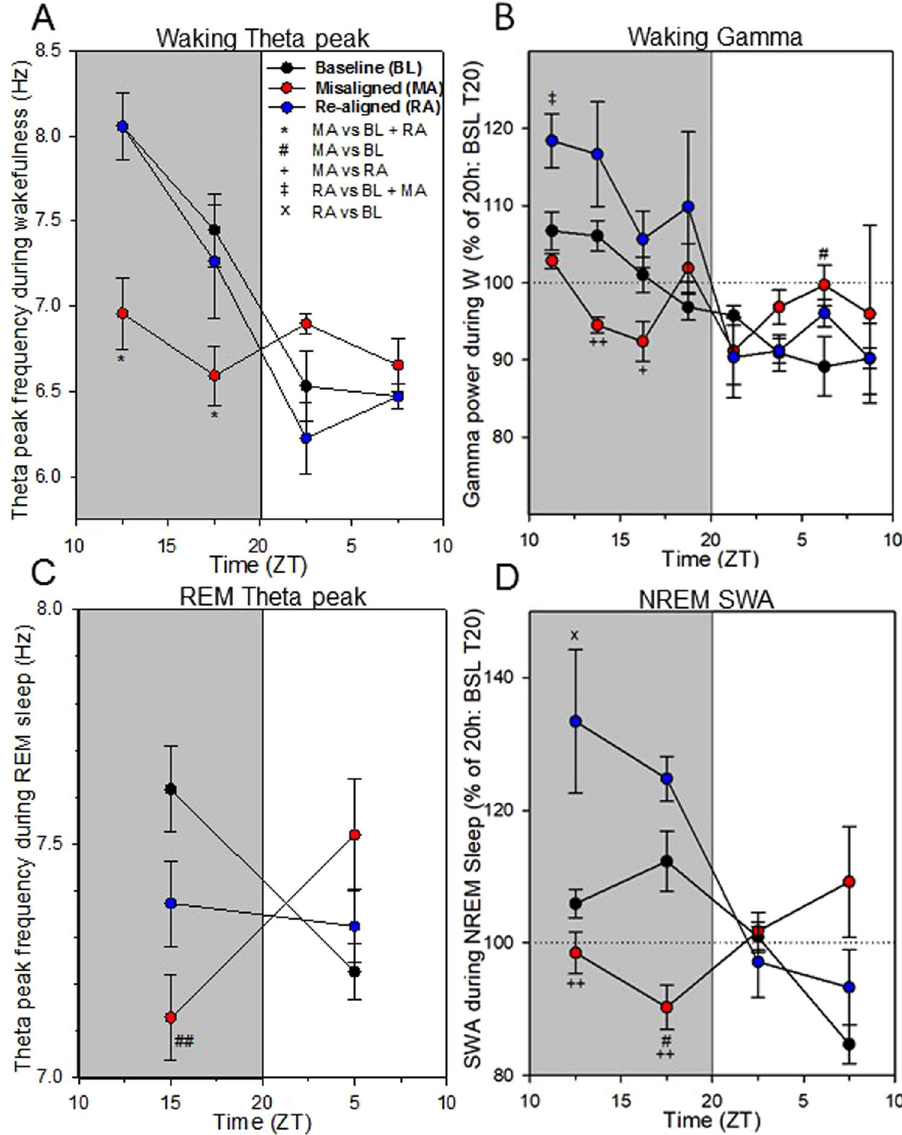
Figure 5. Time course analyses of EEG power density and theta-peak frequency (TPF) during vigilance states. ( A ) Time course of TPF (AVG ± SEM) during wakefulness for the baseline, misaligned and re-aligned T20 cycles. ( B ) Time course of EEG gamma power during wakefulness for the baseline, misaligned and re-aligned T20 cycles. ( C ) Time course of TPF (AVG ± SEM) during REM sleep for the 3 T20 cycles. ( D ) Time course of EEG slow wave activity during NREM sleep for the 3 T20 cycles. EEG slow wave activity (mean ± SEM) was expressed relative to the 20 hours of the baseline T20 cycle ( = 100%). Intervals of EEG spectral power and TPF with significant effect of T20 cycle (repeated measures ANOVA, P < 0.05) were followed by the Tukey post-hoc tests (between the 3 T20 cycles): Asterisks ( * P < 0.05) indicate that the misaligned T20 cycle is different from both baseline and re-aligned T20 cycles; # symbols ( # P < 0.05; ## P < 0.01), misaligned T20 cycle is different from the baseline T20 cycle; plus symbols ( + P < 0.05; ++ P < 0.01), misaligned T20 cycle is different from the re-aligned T20 cycle; ‡ symbol ( ‡ P < 0.05) indicates that the re-aligned T20 cycle is different from both baseline and misaligned T20 cycles; and X symbol ( X P < 0.05) indicates that the re-aligned T20 cycle is different from the baseline T20 cycle